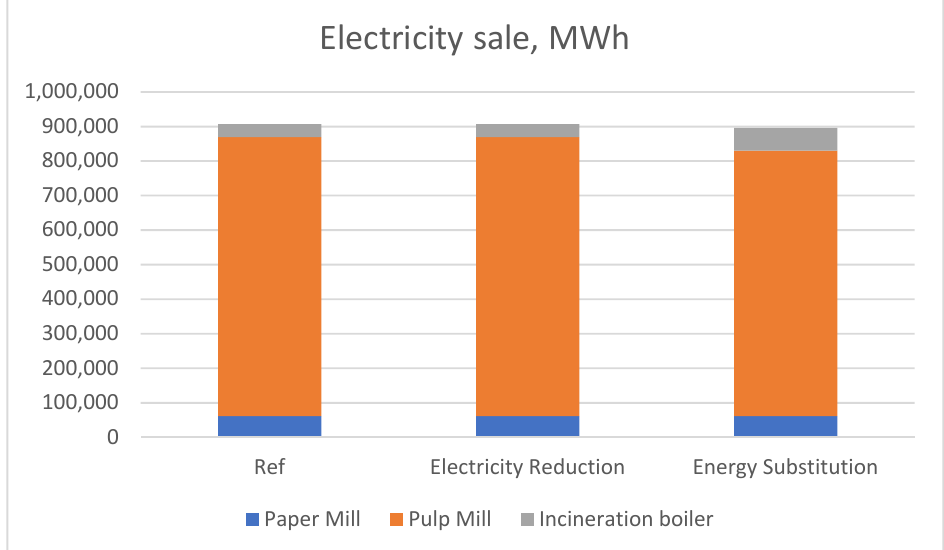
Figure 5. The power sale for each case.